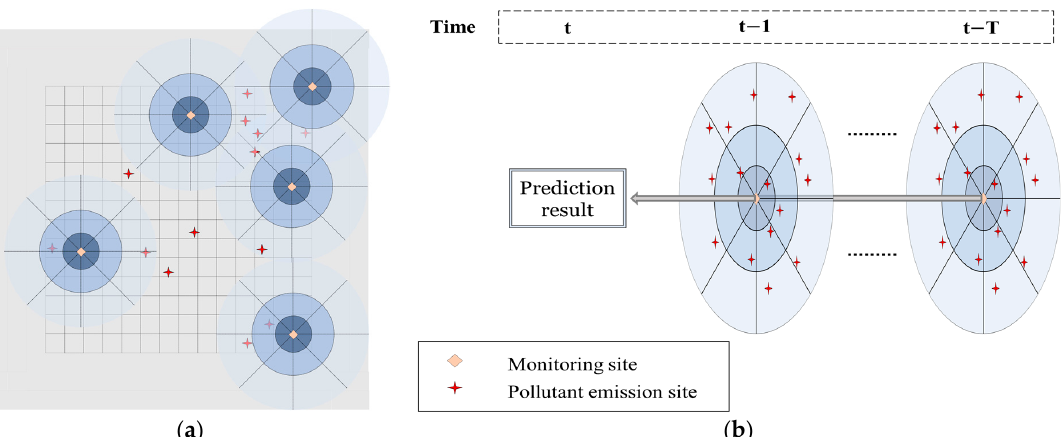
Figure 2. Illustration of spatial-temporal feature engineering. ( a ) Spatial dependence; ( b ) temporal dependence.